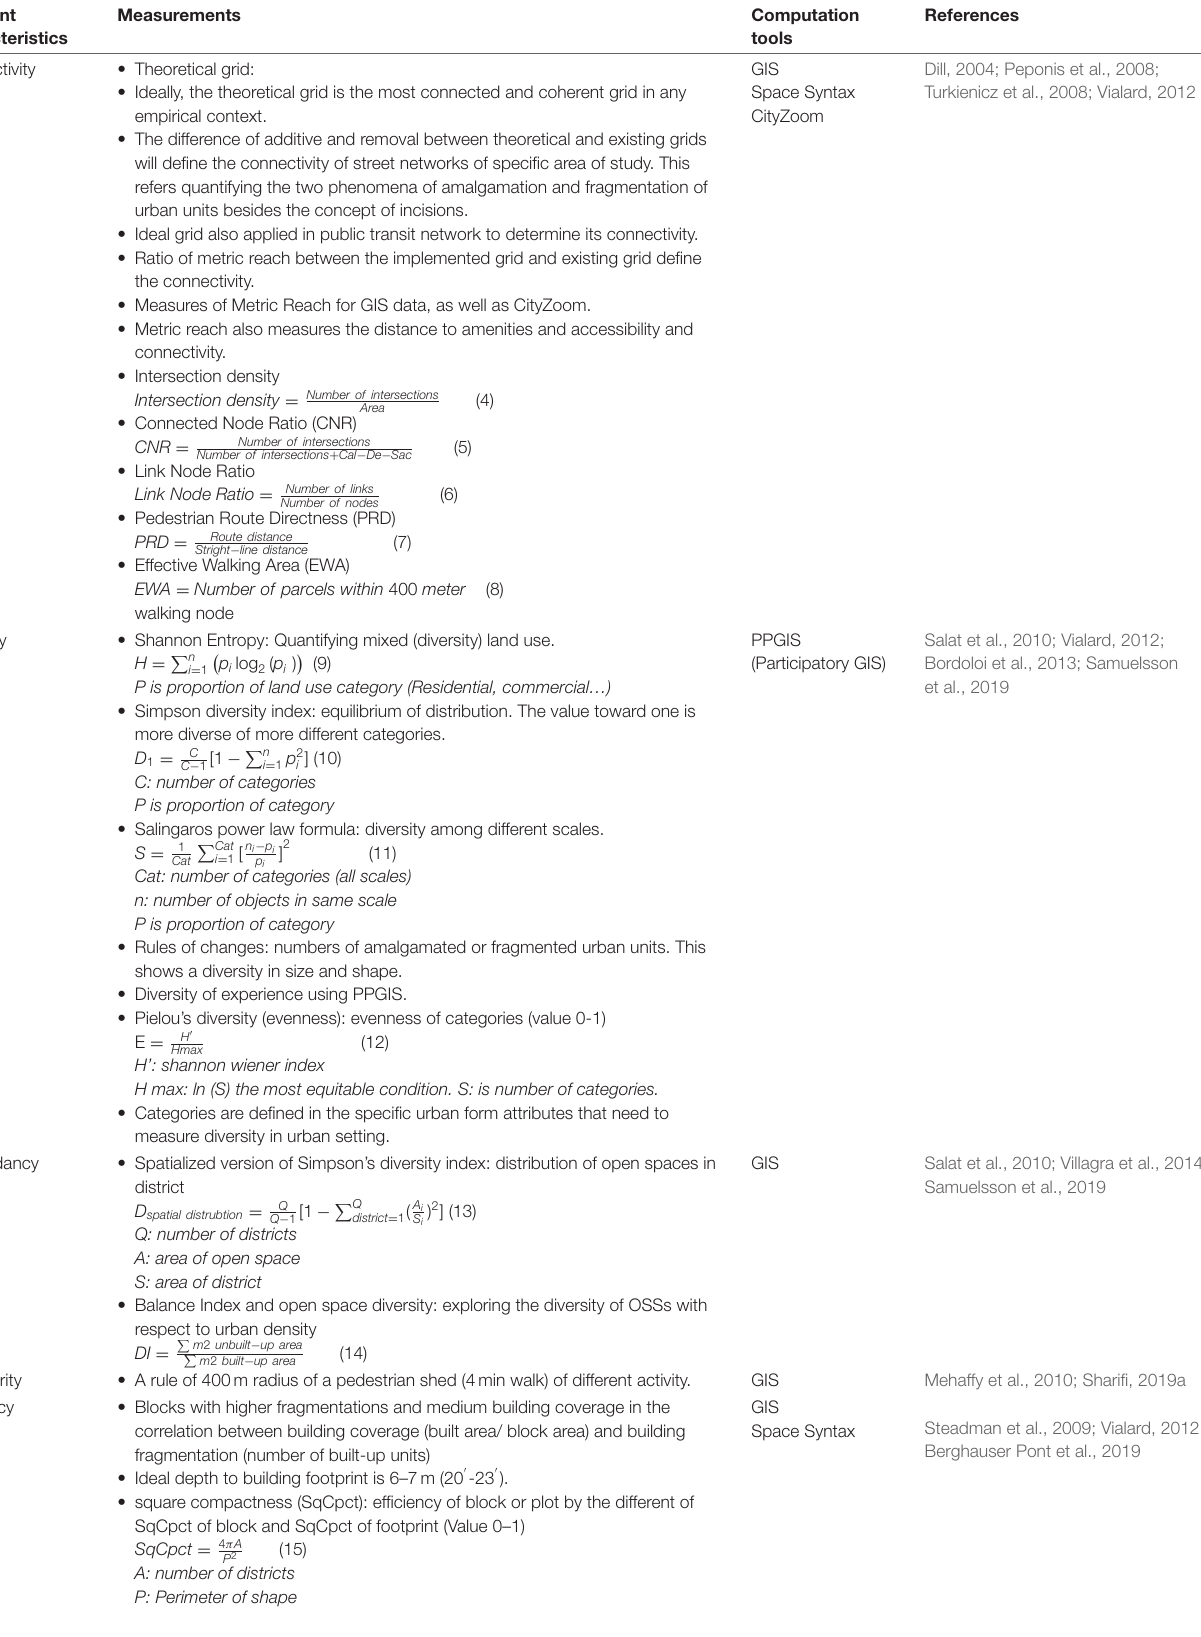
TABLE 3 | Quantitative measurements of resilient